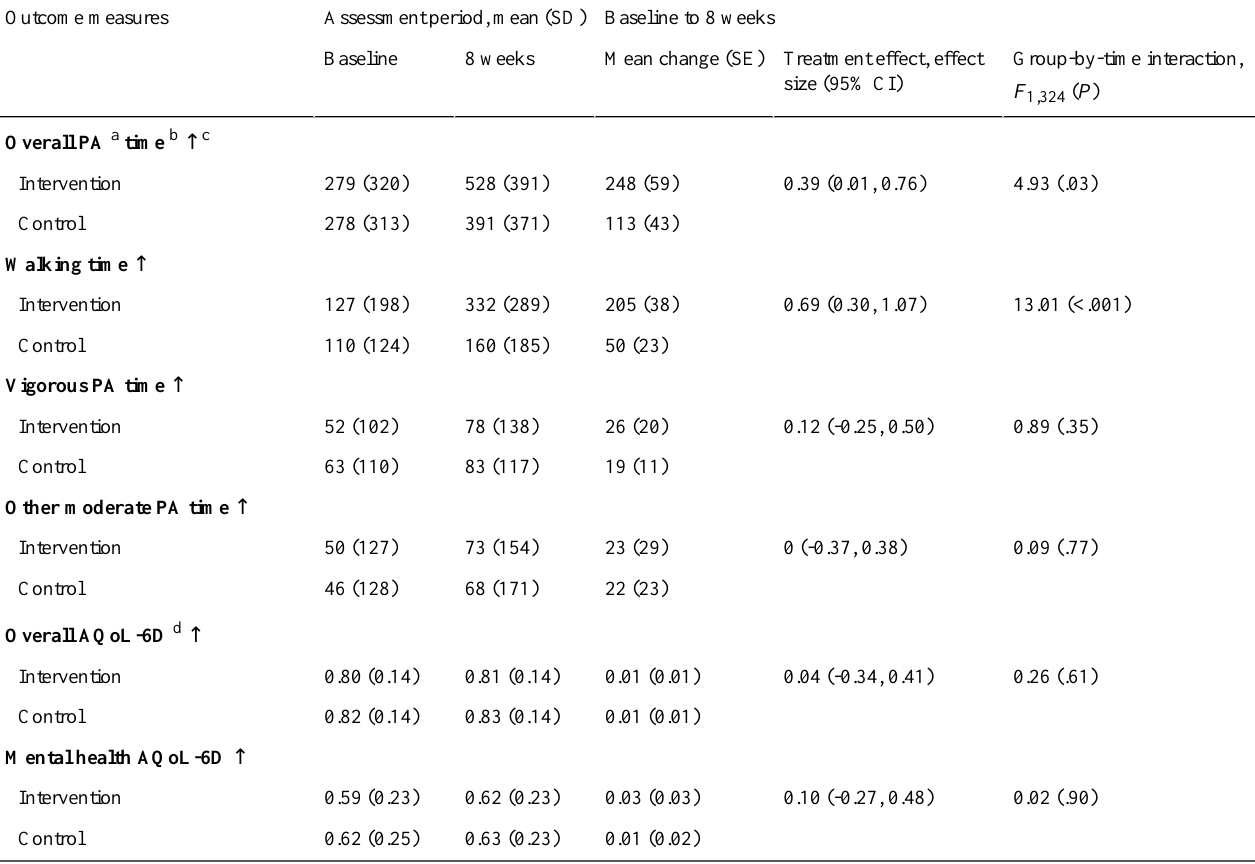
Table 2. Outcome measures at baseline and at 8-week follow-up.